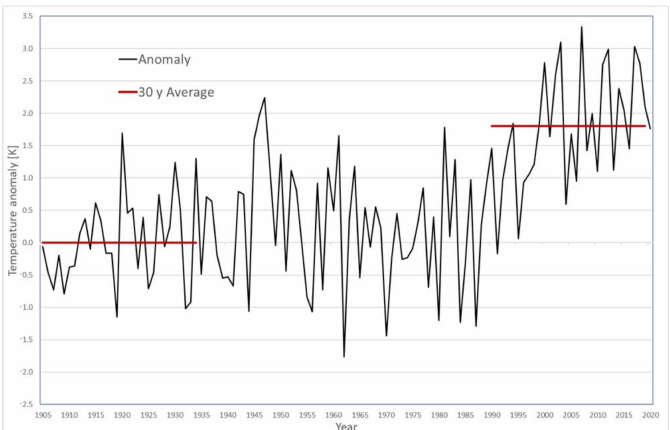
Figure 2. Anomaly of the spring (March—June) temperature (black) at the target area, relative to the period 1906 to 1935. The two red horizontal lines give the 30-year-average spring temperature for the periods 1906 to 1935 and 1991 to 2020. The averages of the two periods differ significantly ( p -value < 0.01).